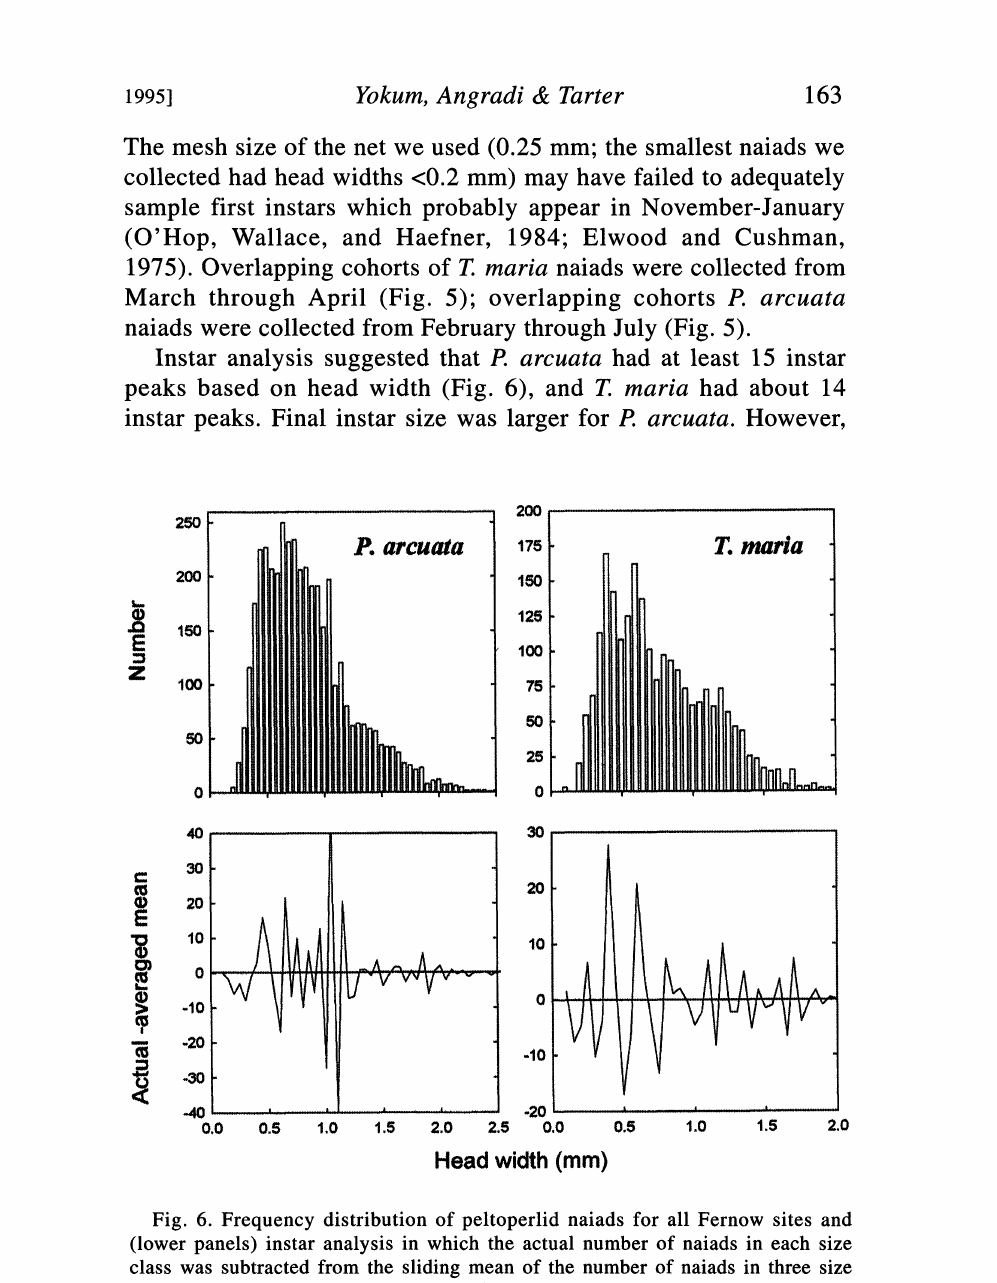
Fig. 6. Frequency distribution of peltoperlid naiads for all Fernow sites and (lower panels) instar analysis in which the actual number of naiads in each size class was subtracted from the sliding mean of the number of naiads in three size classes (mean of the size class in question and the next smallest and next largest size class). Positive peaks are putative